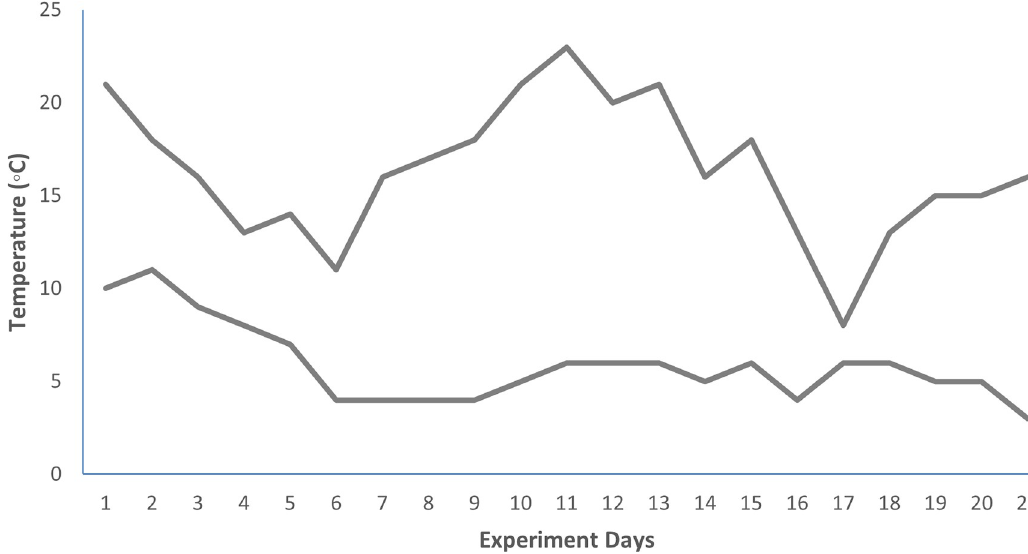
Fig 1. Daily minimum and maximum air temperatures during pot trial of extract coated urea